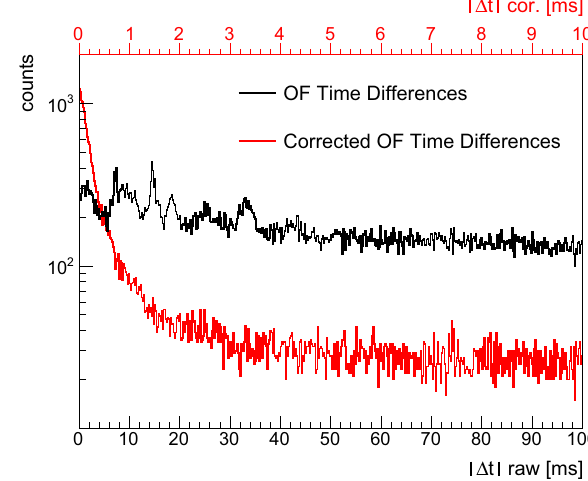
2615 keV γ ’s. The four most prominent γ peaks (denoted by larger labels) are utilized for LMO detector energy calibration. Right: Cali- bration spectra for LDs with X-ray fluorescence during irradiation with a high activity 60 Co source. The ∼ 17 keV X-ray line is used for a linear LD absolute energy calibration